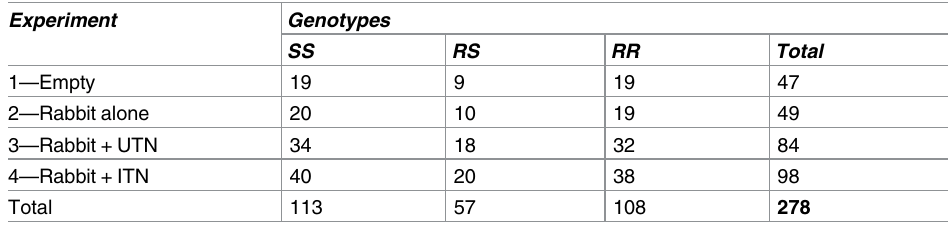
Table 2. Number of releasesperformed per genotype and